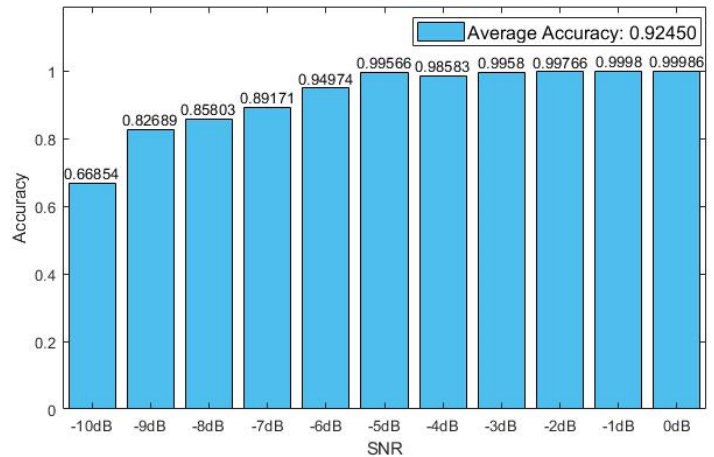
Figure 5. The recognition rates of CNN-1D-AM with 11 values of SNR on the testing dataset.